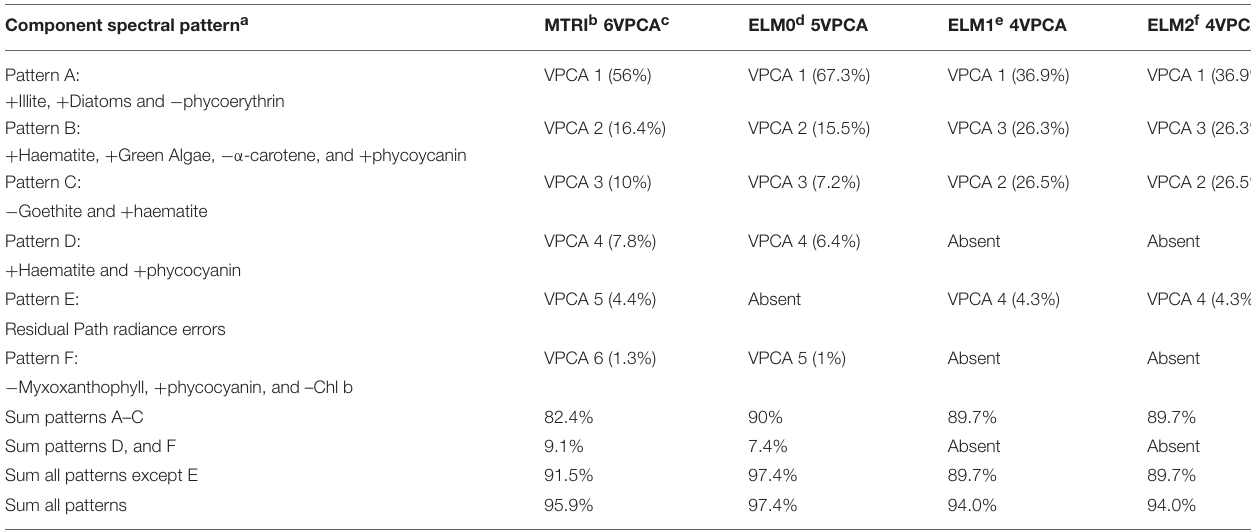
TABLE 2 | Correlation of spectral patterns and variance